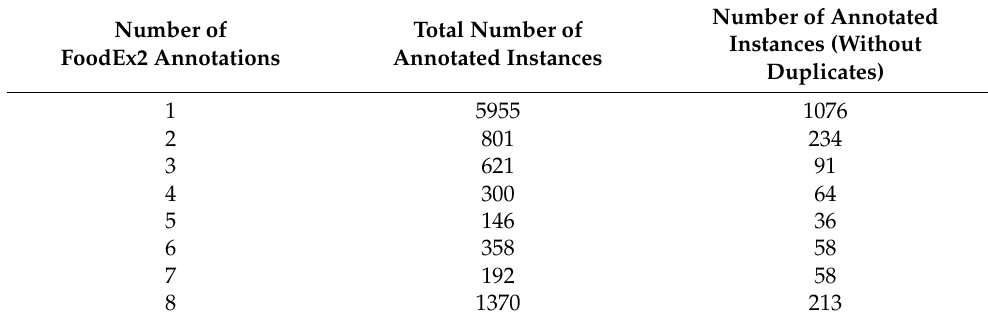
Table 1. Descriptive statistics about the FoodEx2 annotations on the FoodBase dataset.